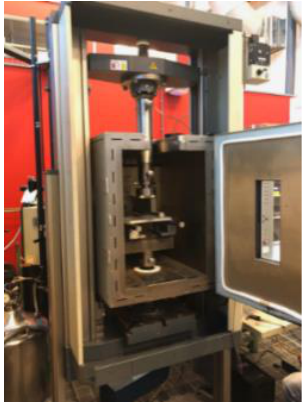
Fig. 11 3-Point bending test setup for elevated